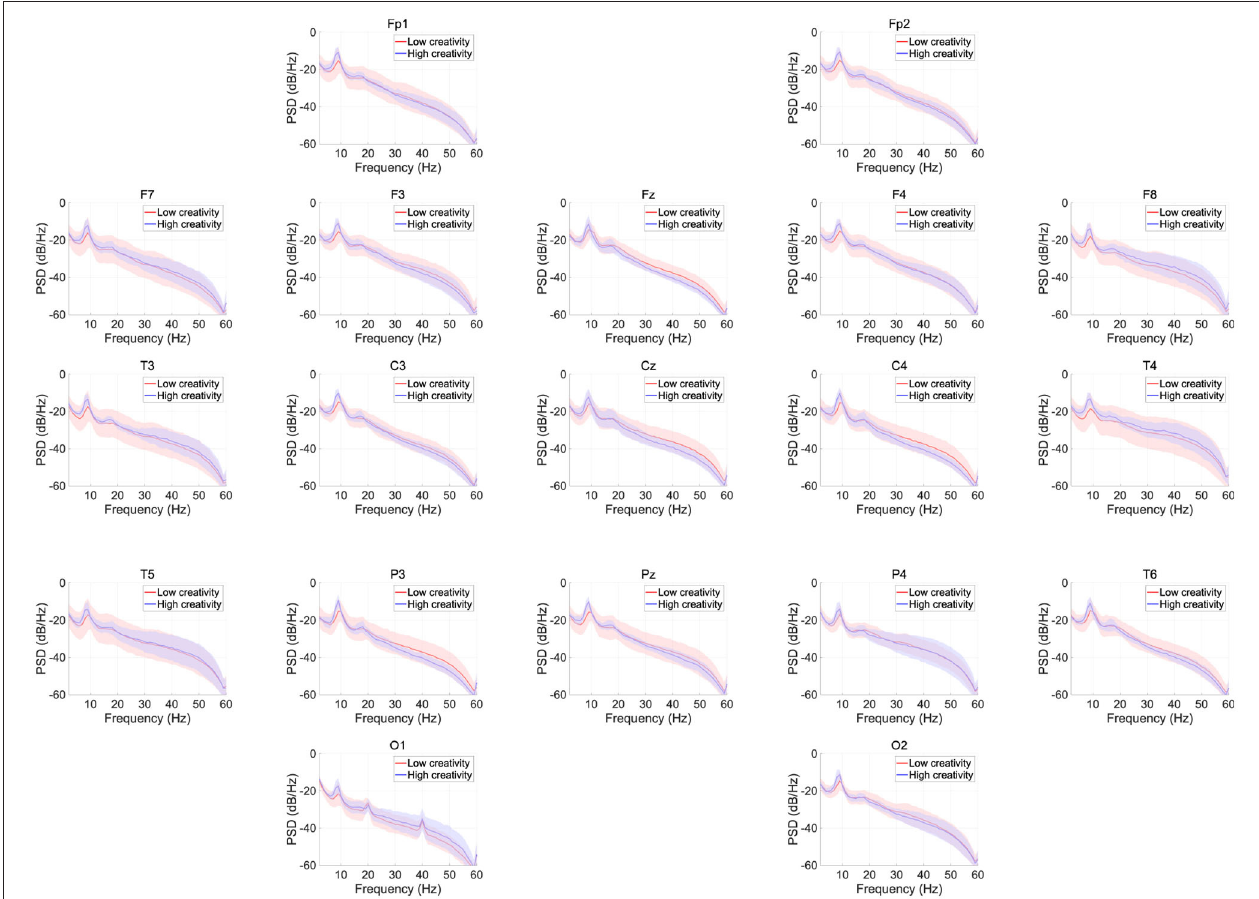
FIGURE 1 | EEG power spectral density (PSD) for the high- and low-creativity groups. Solid lines and shaded areas indicate mean and standard deviation in each group. We observed no significant differences after adjustment for false discovery rate (FDR) with q < 0.05.